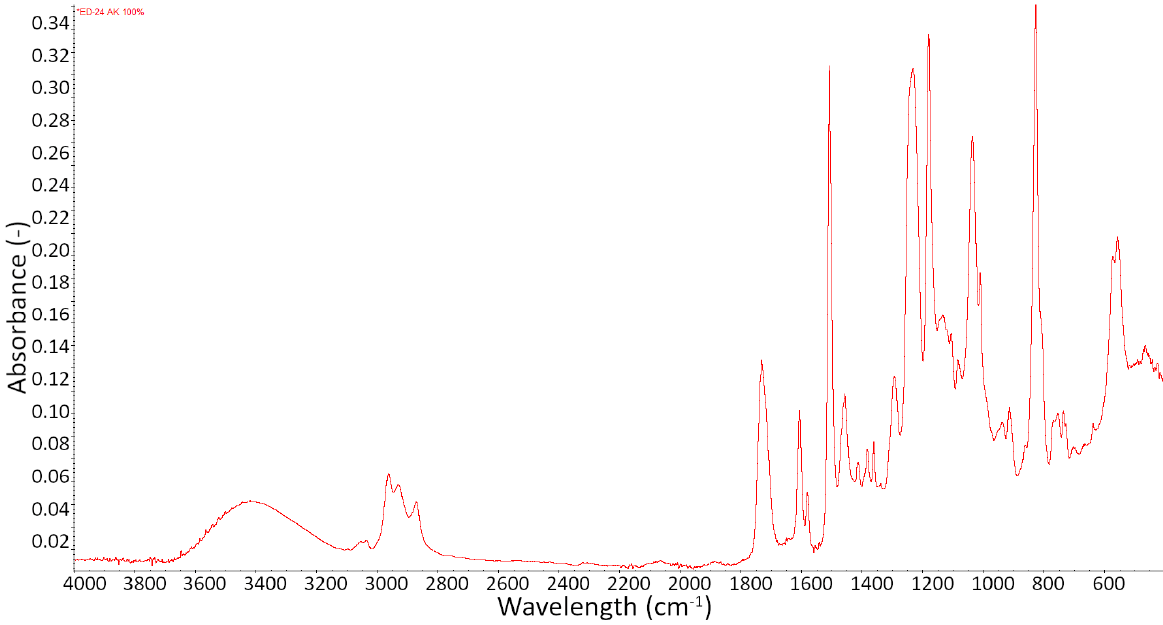
Figure 7. FT-IR spectrum of ED-24 AK resin. In the spectrum of NBR modified with 5% of ED-20 (Figure 8), typical absorption peaks for NBR rubber and the disappearance of the peak around 3400 cm − 1 (-OH groups) can be observed. The peak at 1550 cm − 1 -C=C- from butadiene decreases significantly, which indicates the disappearance of this type of bonds in NBR. Typical Epidian 5 peaks appear 1050 cm − 1 from the C-O bond and 900 cm − 1 peak for the presence of an epoxy ring and increased peak at 550 cm − 1 , which confirms the resin